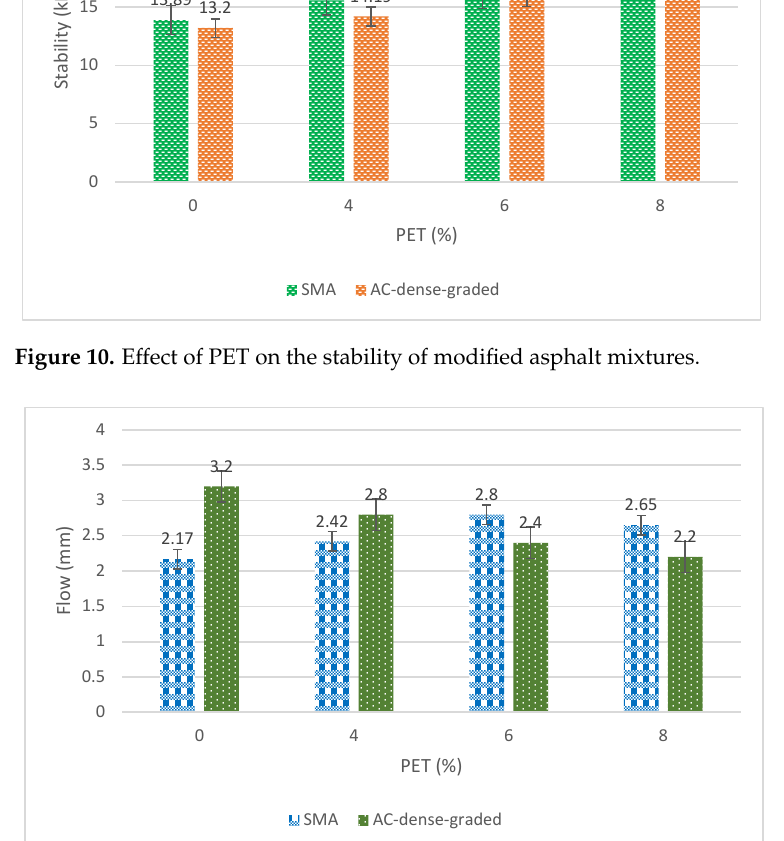
Figure 11. Effect of PET on the flow properties of asphalt mixtures.